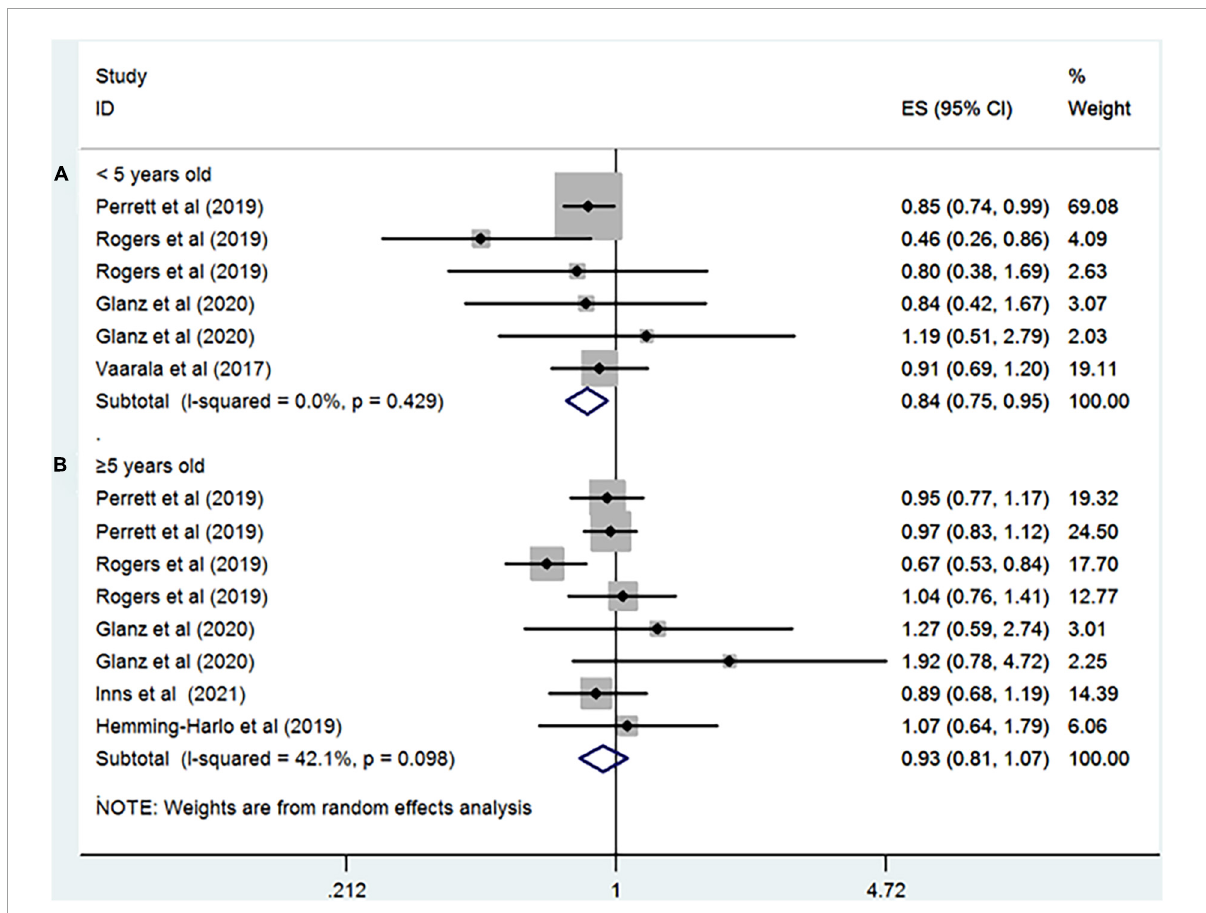
FIGURE4 Rotavirus vaccination exposure and the subsequent risk of T1D (A) aged < 5 years at the end of study and (B) aged ≥ 5 years at the end of